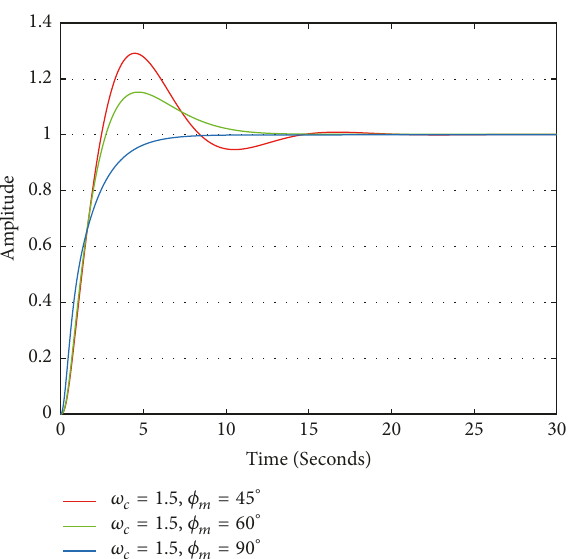
Figure 17: Step response of 𝑃 2 (𝑠) with the same 𝜔 𝑐